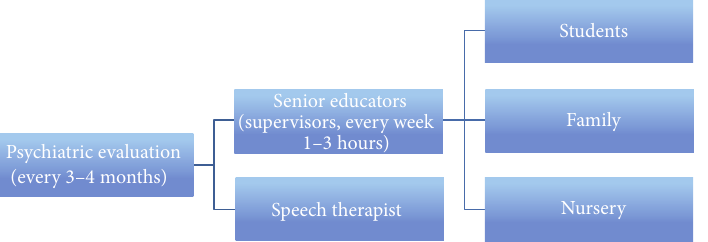
Figure 1: Providers of the educational